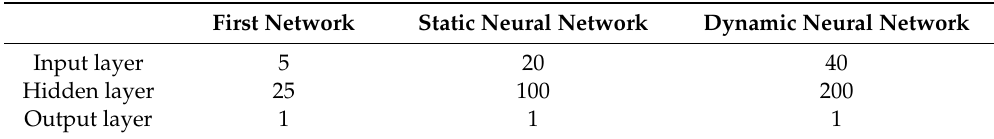
Figure 10. ( a ) Distance assessment factor for static feature sets; ( b ) Distance assessment factor for dynamic feature sets. Table 3. Neural network parameter settings.